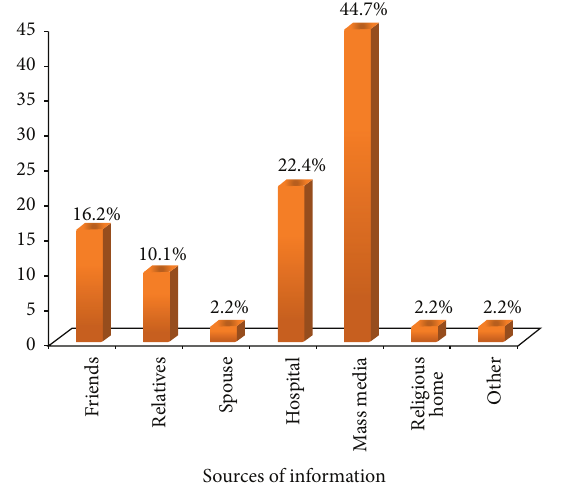
Figure 2: Respondents’ sources of information about cervical cancer.